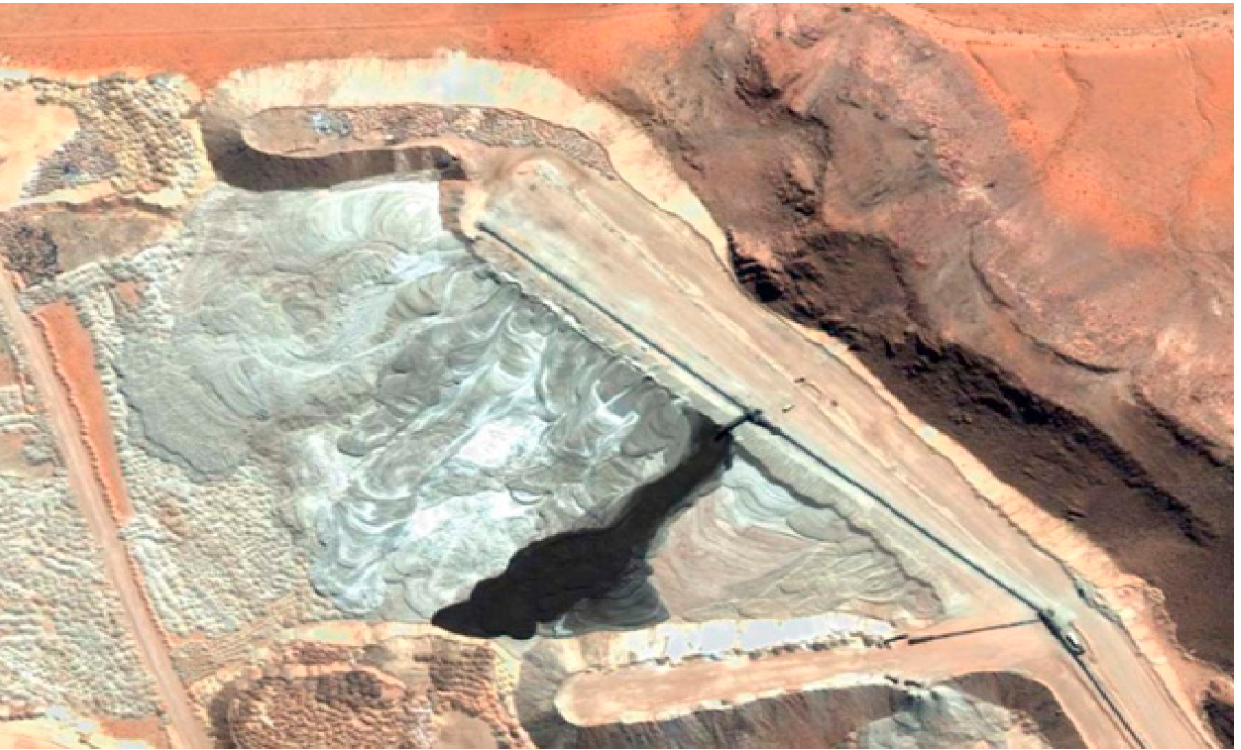
Figure 10. Mantos Blancos Aerial View of Disposal of Filtered Coarse Tailings [12].